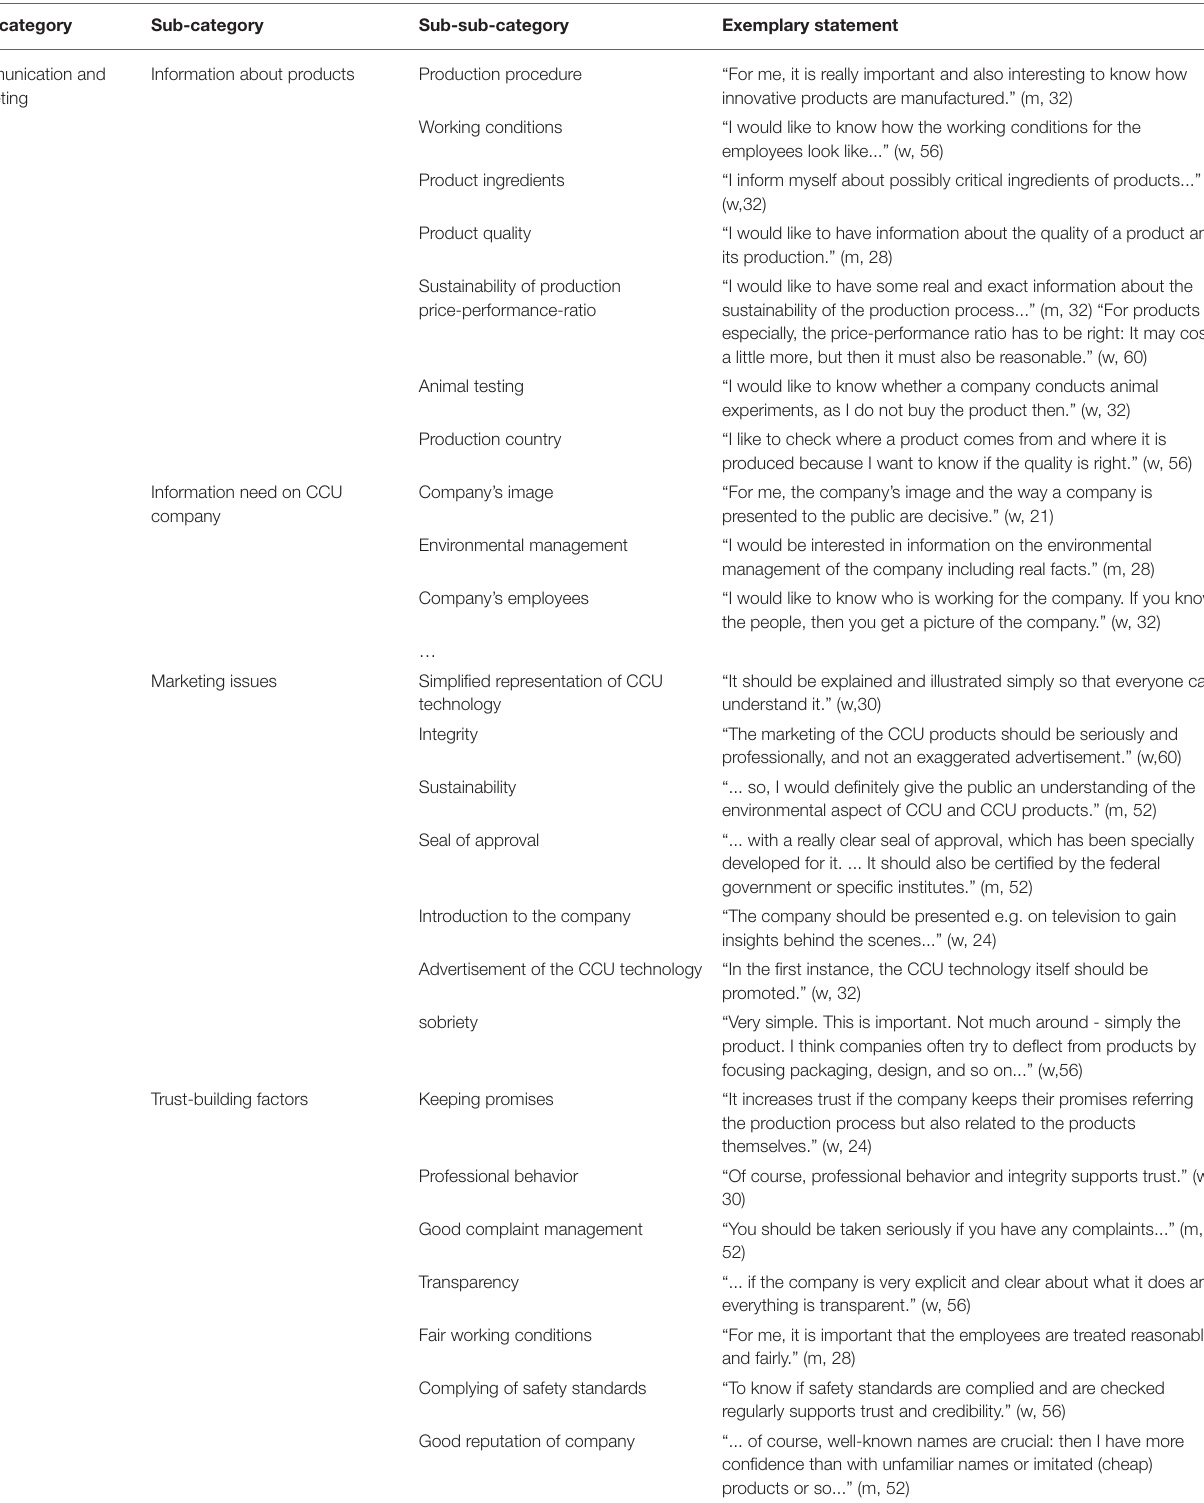
TABLE 1B | Category System of the Qualitative Analysis Focusing on Information- and Trust-Relevant Aspects of